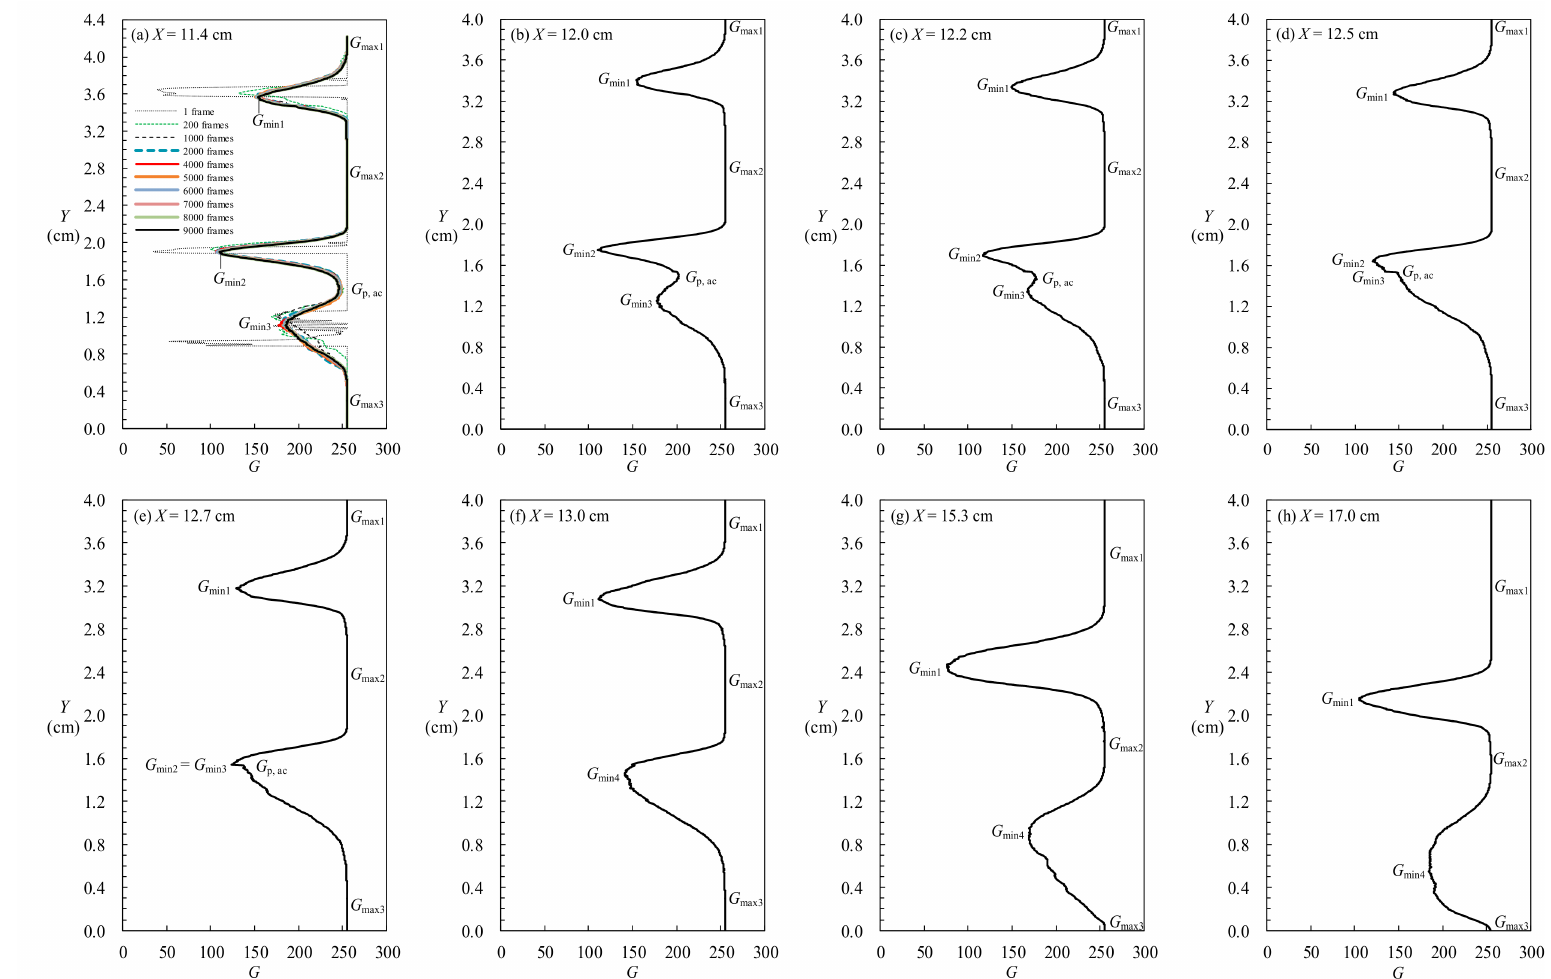
Figure 11. ( a ) One IGLD and several EAGLDs obtained at X = 11.40 cm; the EAGLD for 9000-frame images at ( b ) X = 12.0 cm; ( c ) X = 12.2 cm; ( d ) X = 12.5 cm; ( e ) X = 12.7 cm; ( f ) X = 13.0 cm; ( g ) X = 15.3 cm; ( h ) X = 17.0